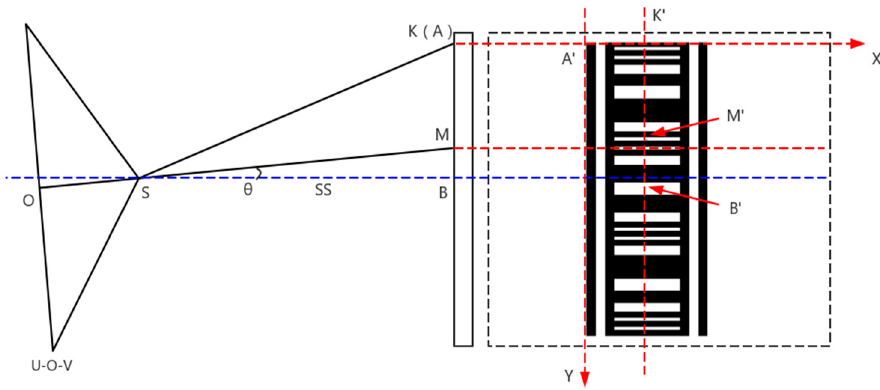
Figure 11. The relationship of the horizontal distance from the bar code to the projection center and the relevant geometric lines and points in the camera and object coordinate systems.